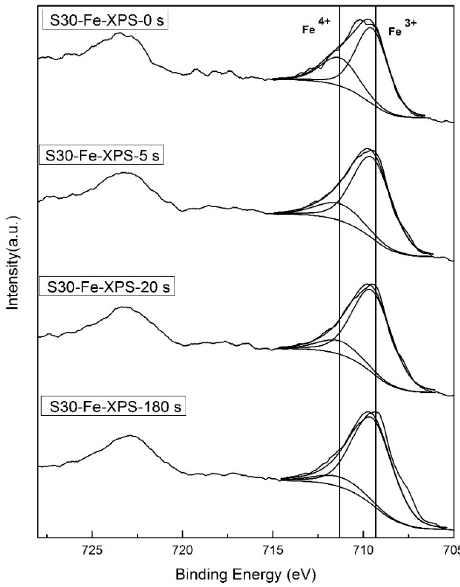
Figure A2. XPS spectra of Fe 2p 3/2 of the polished surface of S30 after Ar + been etched for 0 s, 5 s, 20 s, and 180 s.